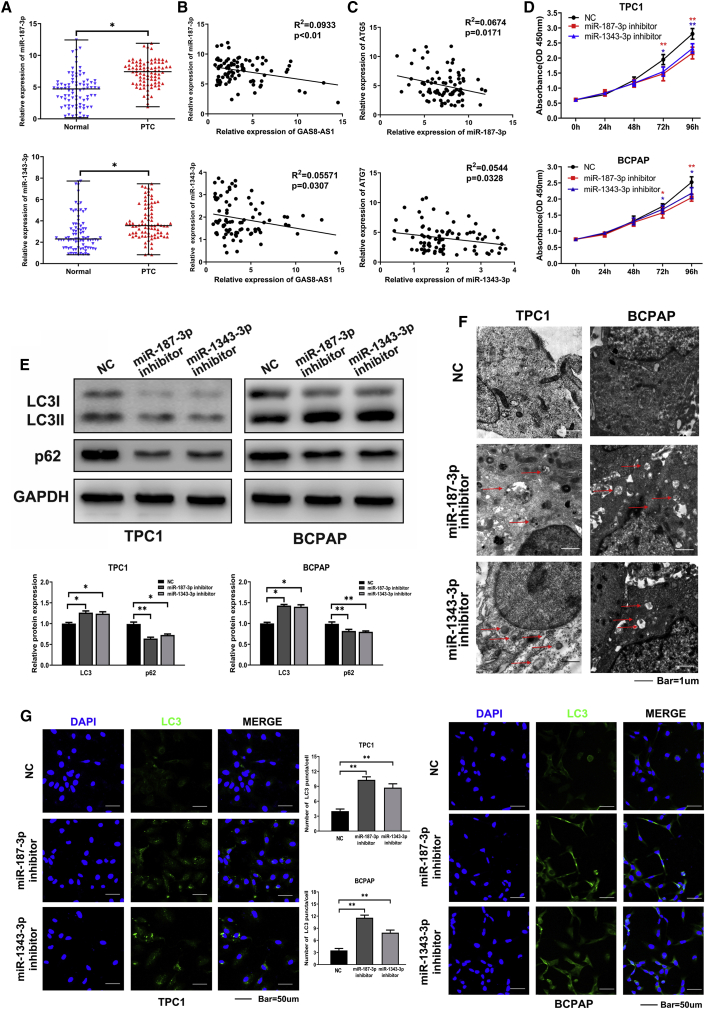
Knockdown of miR-187-3p and miR-1343-3p Inhibited PTC Cell Proliferation but Promoted Autophagy(A) qRT-PCR determination of the relative expression of miR-187-3p and miR-1343-3p in 84 pairs of PTC tissues and adjacent non-cancerous tissues. Statistical differences were analyzed using the Wilcoxon signed-rank test; data are shown as the median and range. (B) The correlations between GAS8-AS1 and miR-187-3p and miR-1343-3p in PTC tissues were analyzed using Pearson’s correlation. (C) The correlations between miR-187-3p and ATG5 and miR-1343-3p and ATG7 in PTC tissues were analyzed using Pearson’s correlation. (D–G) Growth was evaluated using CCK-8 (D), autophagy-relevant proteins (LC3, p62) were detected by western blotting (E), autophagosomes were shown using TEM (red arrows) (F), and LC3 puncta were evaluated using IF (G) after miR-187-3p inhibitor and miR-1343-3p inhibitor transfection in TPC1 and BCPAP cells. Statistical differences were analyzed using the independent samples t test; data are shown as the mean ± standard error of the mean based on three independent experiments. ∗p < 0.05, ∗∗p < 0.01.